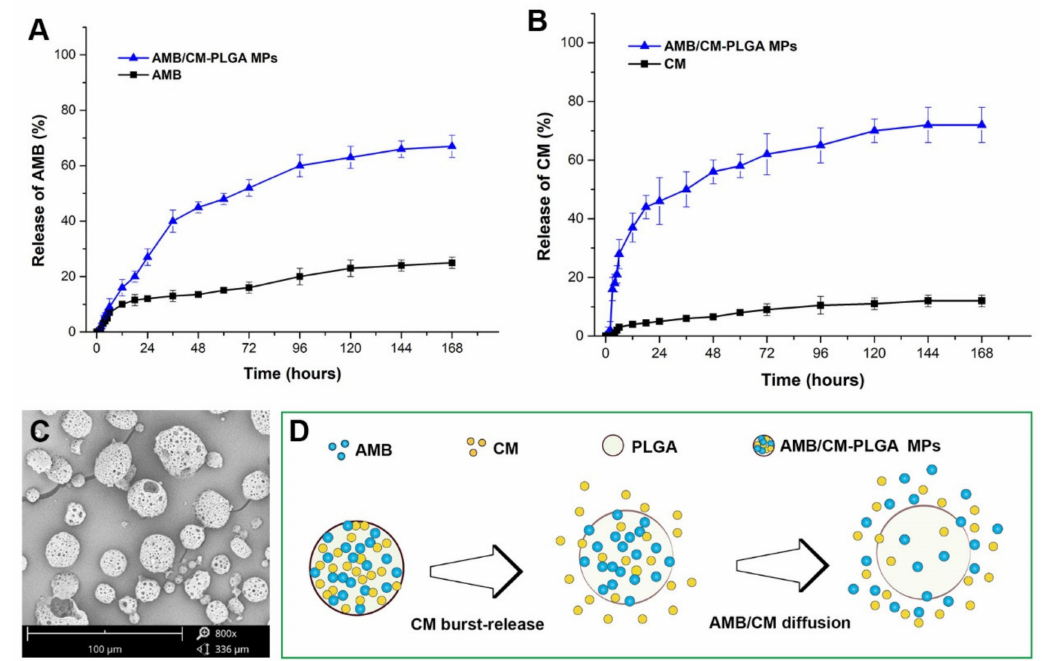
Figure 2. AMB and CM release from the AMB/CM-PLGA MPs. ( A ) In vitro drug release profiles of AMB within 168 h. ( B ) In vitro drug release profiles of CM within 168 h. ( C ) AMB/CM-PLGA MPs were degraded within 24 h. ( D ) Proposed mechanism of sequential drug release.